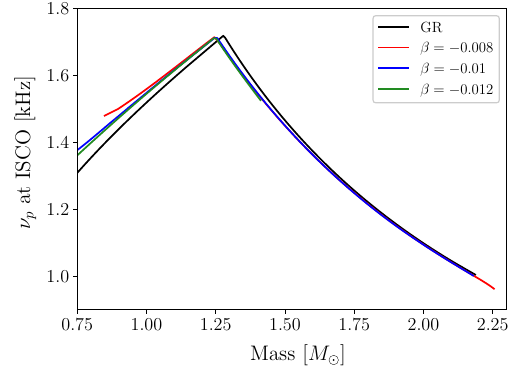
Fig. 10 Orbital frequency at the ISCO radius as a function of the grav- itational mass for GR and TMST with the monotonic coupling function (12), for n = 1, different β values and f = 0 Hz